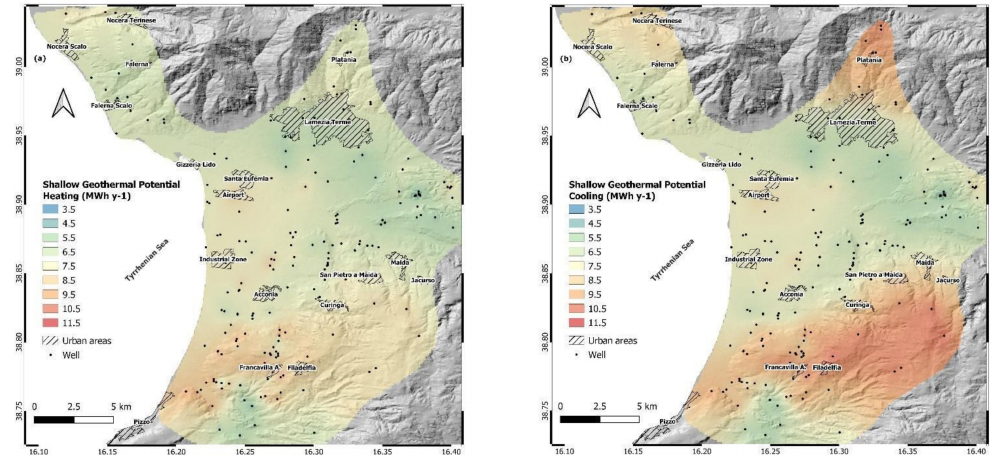
Figure 5. Shallow geothermal potential map for space ( a ) heating and ( b ) cooling in Sant’Eufemia plain with 100-m BHE